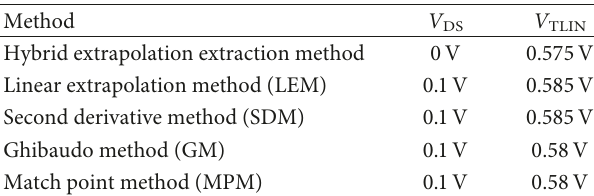
Table 2: Comparison of V TH extraction methods for 180nm test